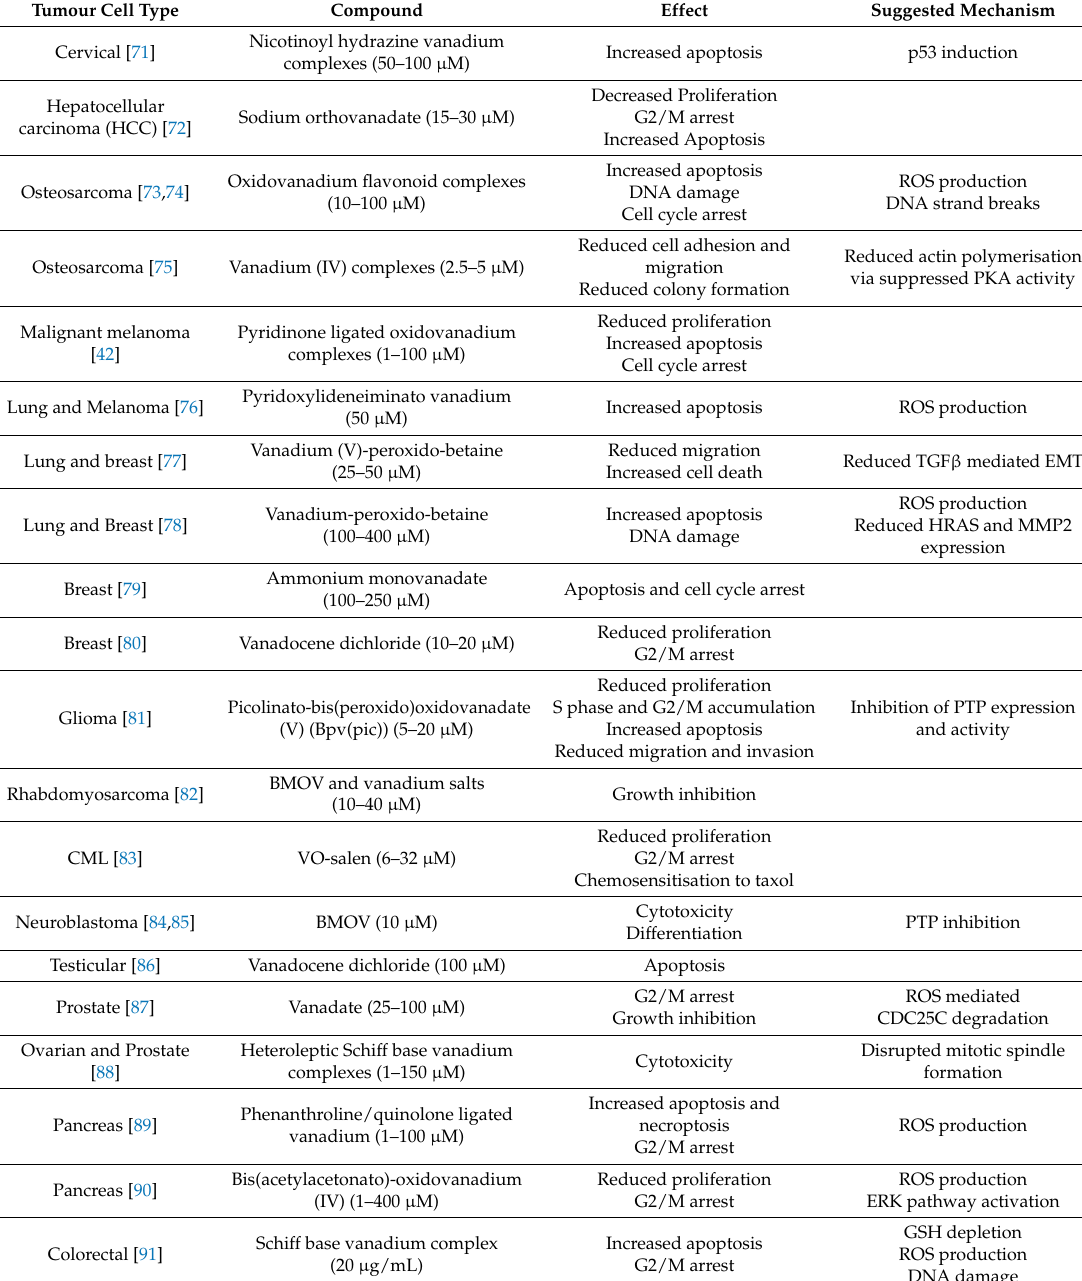
Table 1. Summary of some reported anti-cancer activities of vanadium in cancer cell